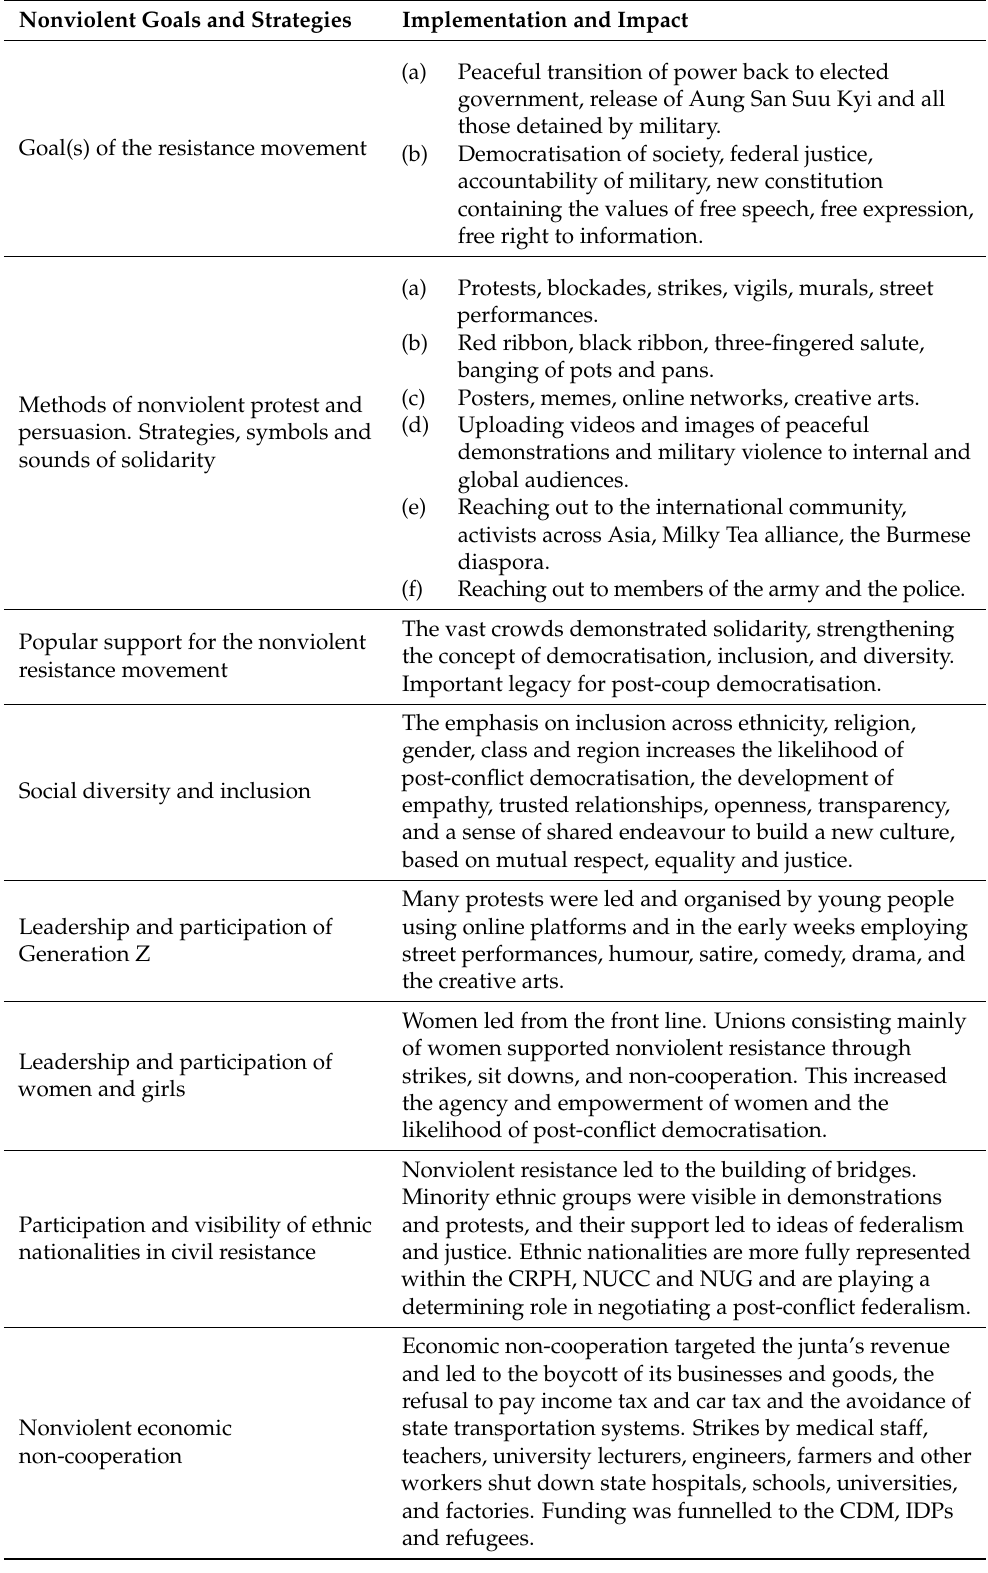
Table A1. Nonviolent Campaign Goals and Strategies for the Restoration of Democratic Government, Federalism and Civic Inclusion after the Military Coup in February